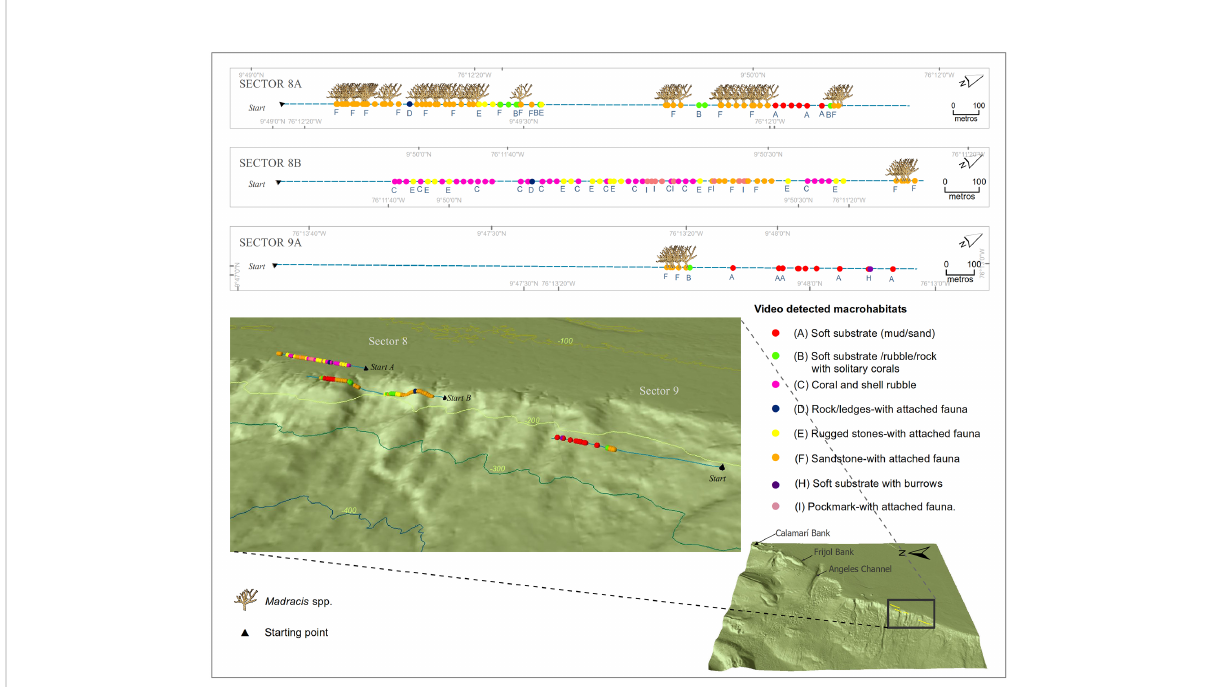
FIGURE 4 Distribution of the macrohabitats identi fi ed in Sectors 8 and 9 of the Corales de Profundidad National Natural Park; area superimposed on the 3D bathymetry map. The occurrence of Madracis spp. coral patches is also